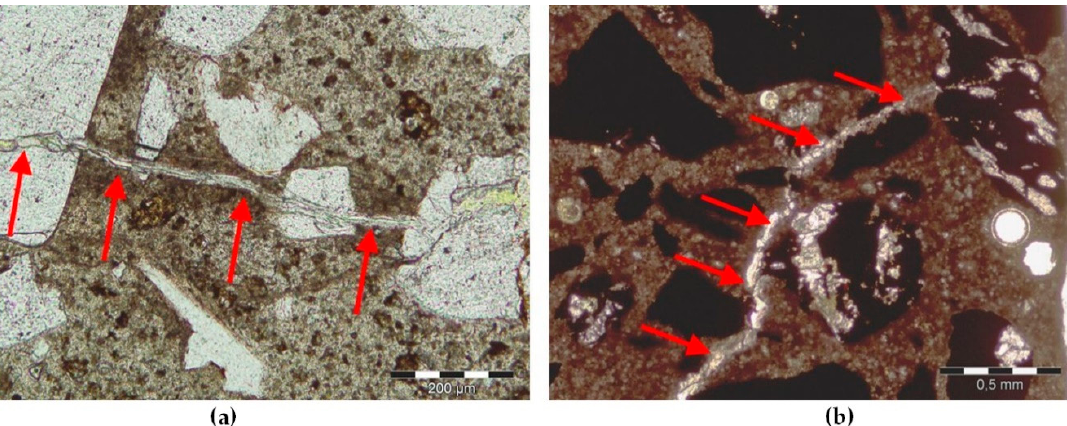
Figure 5. Post-mortem analysis on thin section in PPL, cracked mortar, and aggregate: ( a ) Barite B2, scale bar = 200 μ m; ( b ) Hematite H1, scale bar = 500 μ m.